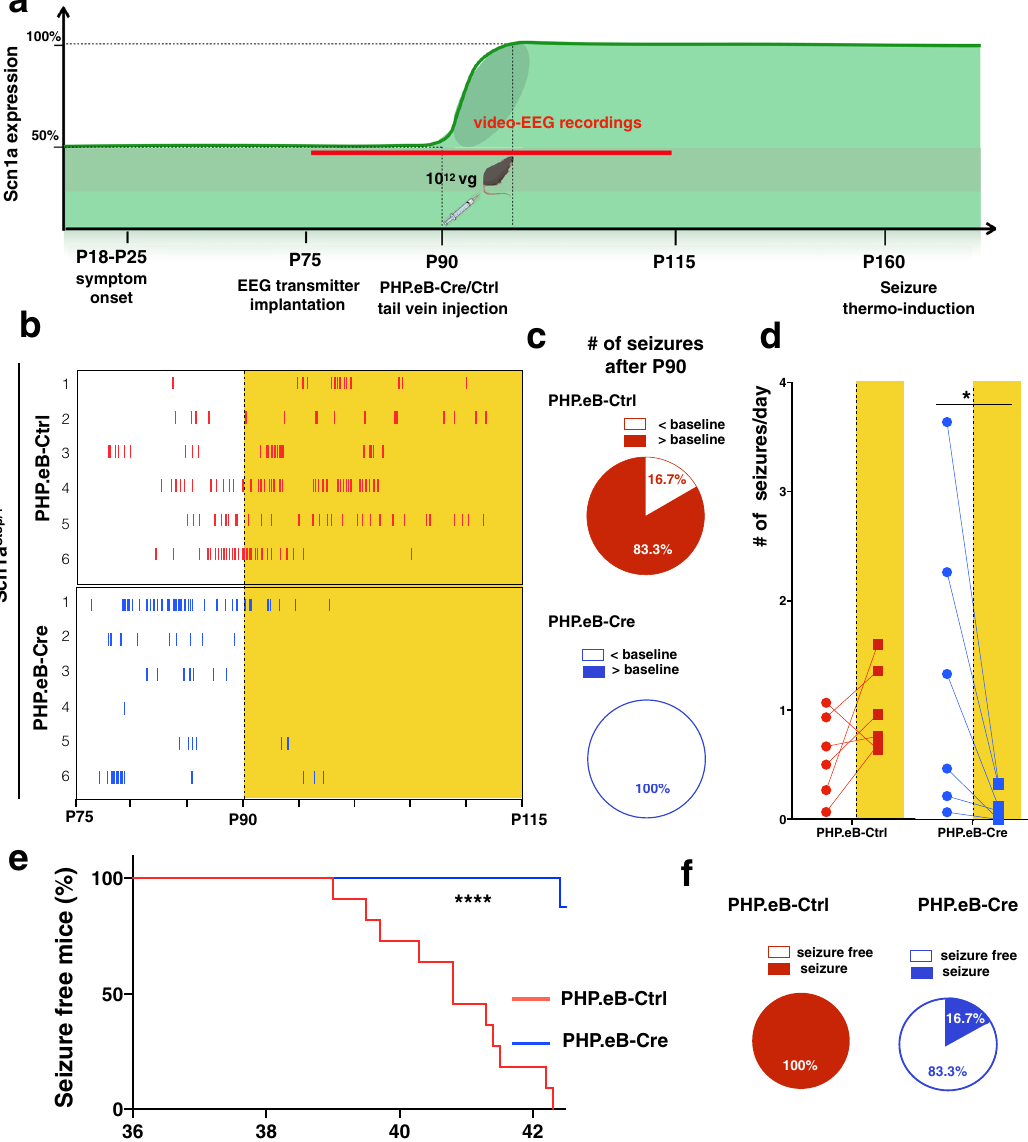
Fig. 8 Re-expression of Scn1a gene in adult mice (P90) rescues seizures in DS mice. a Schematics depicting the experimental timeline: Scn1a Stop / + mice were implanted with EEG transmitters at P70 and, few days after were video-EEG recorded for 2 weeks (baseline). Mice that experienced at least one seizure over the 2 weeks of recordings were randomized and were administrated with either PHP.eB-Cre or PHP.eB-Ctrl through tail vein injections at P90. Thereafter, video-EEG continued for further 25 days, until mice reached postnatal day 115. Created with BioRender.com. b Raster plot showing all generalized tonic-clonic seizures (Racine scale stages 4 and 5) in 6 Scn1a Stop/ + -Ctrl injected mice and 6 Scn1a Stop/ + -Cre mice c Pie chart showing the proportion of Ctrl- and -Cre-injected Scn1a Stop/ + mice with an increased or decreased number of seizures compared to baseline after viral delivery ( p = 0.0152; two-sided Fisher ’ s exact test). d Seizure frequency during the baseline period and after viral injection in both Ctrl- and Cre-injected Scn1a Stop/ + mice. Seizure frequency in the baseline between the two groups (* p = 0.235, t-test). Seizure frequency before and after viral administration in Scn1a Stop / + -Ctrl ( p = 0.53, two-way ANOVA with Sidak ’ s multiple comparison, n = 6) and Scn1a Stop / + -Cre; * p = 0.028, two-way ANOVA with Sidak ’ s multiple comparison, n = 6), e Percentage of Scn1a Stop/ + -Ctrl and Scn1a Stop/ + -Cre mice remaining seizure-free after thermal induction ( n = 6 for each group, *** p = 0.0002; Mantel-Cox log-rank test). f Pie charts showing the percentage of Scn1a Stop/ + -Ctrl and for Scn1a Stop/ + -Cre mice with or without induced thermal seizures ( p = 0.0152; two-sided Fisher ’ s exact test). Source data are provided as a Source Data fi